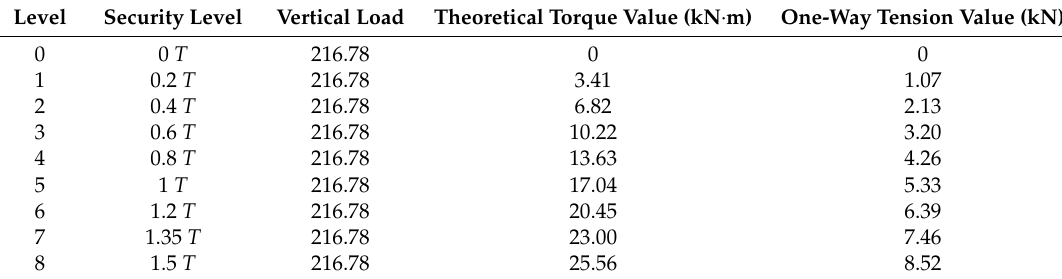
Table 4. Loading levels of torque T.